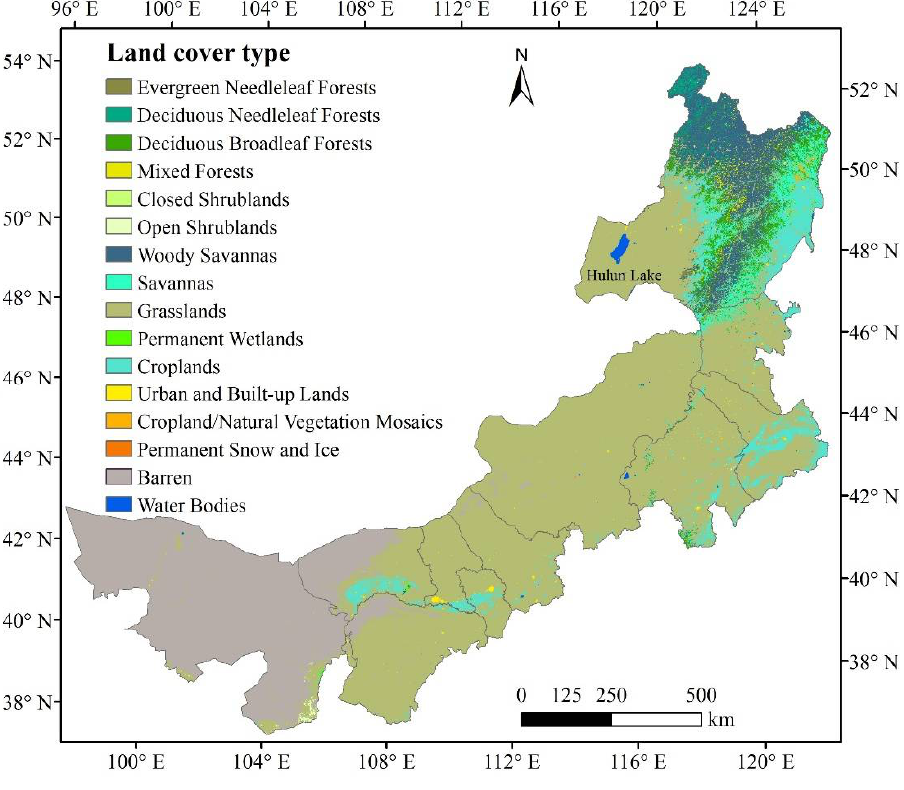
Figure 2. Land cover map of Inner Mongolia in 2019.